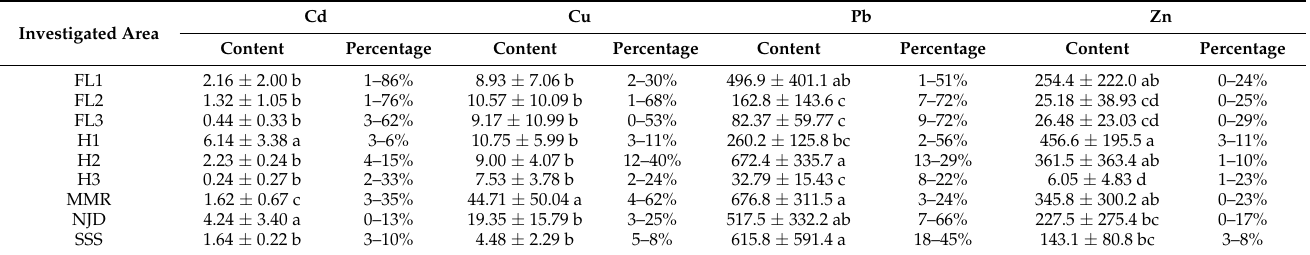
Table 2. DTPA-extractable heavy metal contents and percentage of the total contents (mg kg − 1 ).